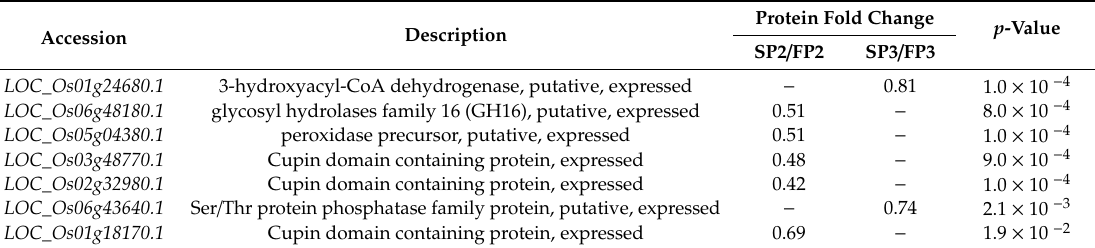
Table 1. The cor-DEGs-DAPs genes enriched in the cell wall GO